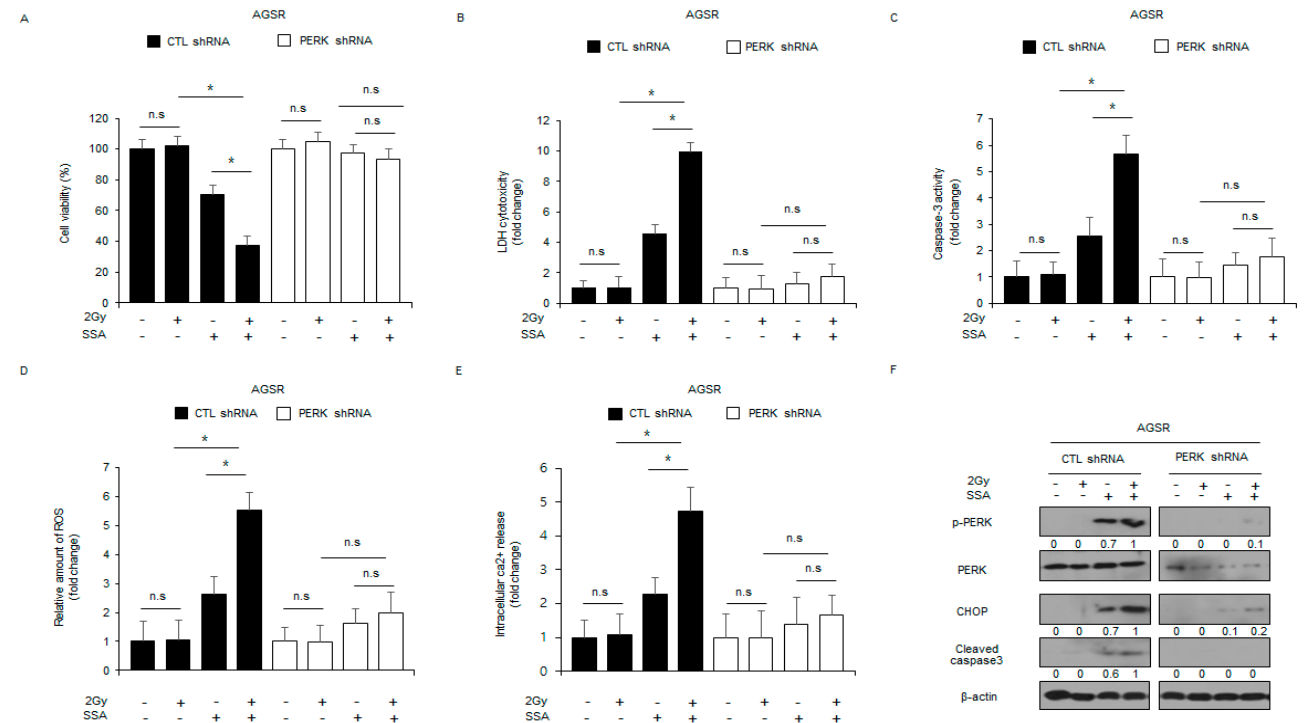
Figure 7. Targeting PERK inhibits apoptotic cell death in radio-resistant GC cells subjected to SSA in combination with 2 Gy. ( A – F ) PERK shRNA stable AGSR cell lines were established after AGSR cells were transfected with PERK shRNA. These cells were exposed to SSA (10 μΜ ), 2 Gy, and SSA/2 Gy, and cell viability, cell cytotoxicity, caspase-3 activity, intracellular ROS release, and intracellular Ca 2+ release were determined along with Western blot analyses examining the levels of p-PERK, PERK, CHOP, and cleaved caspase-3; *, p < 0.05. β -actin was used as a protein loading control.